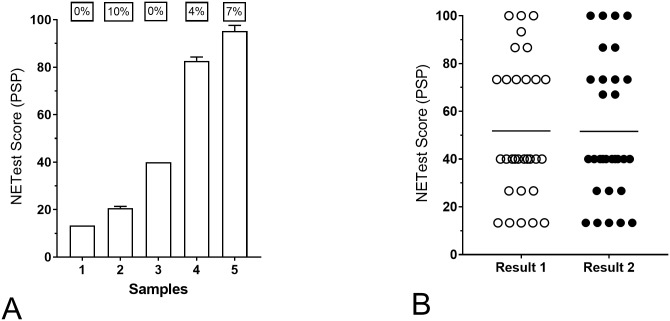
Reproducibility of the PSP assays.6A. Inter-assay reproducibility in five different samples. Each sample was repeated 5–10 times. The scores for each sample exhibited CV of 0–10%. The average CV was 4.2%. Bars are Mean+SD. 6B. Intra-assay reproducibility. Thirty samples with NETest scores spanning the range of reported results were repeated (Result 1 vs. Result 2). The averaged CV for the 30 samples was 1.26%. Line = Mean; CV = co-efficient of variation.